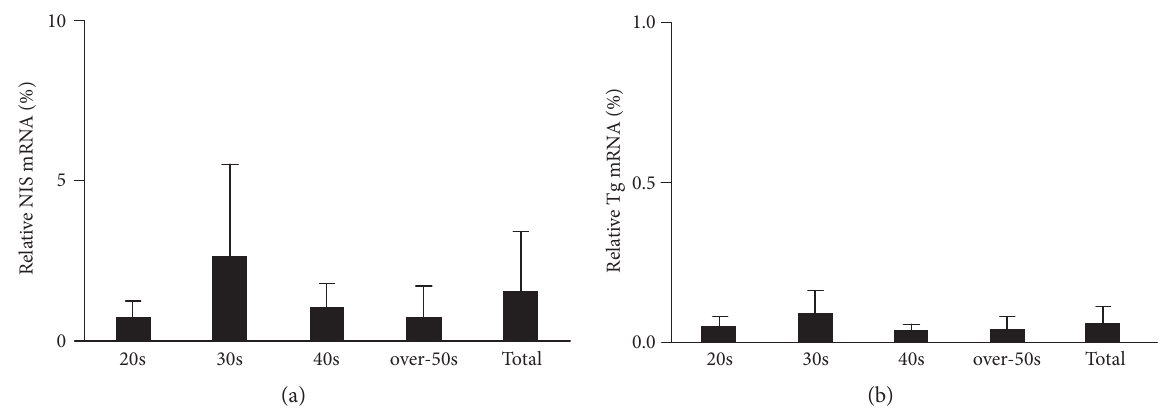
Figure 6: mRNA expression levels of thyroid-related genes in the thymus. The relative amount of mRNA in human thymic tissues is expressed as percentages of levels in normal thyroid tissues. The expression levels of both sodium iodide symporter (NIS) (a) and thyroglobulin (Tg) (b) mRNA are markedly lower in the thymus than in normal thyroid tissues. The mRNA levels were analyzed in the four age groups: 20s, 30s, 40s, and over-50s groups as percentages of each mRNA level found in normal thyroid